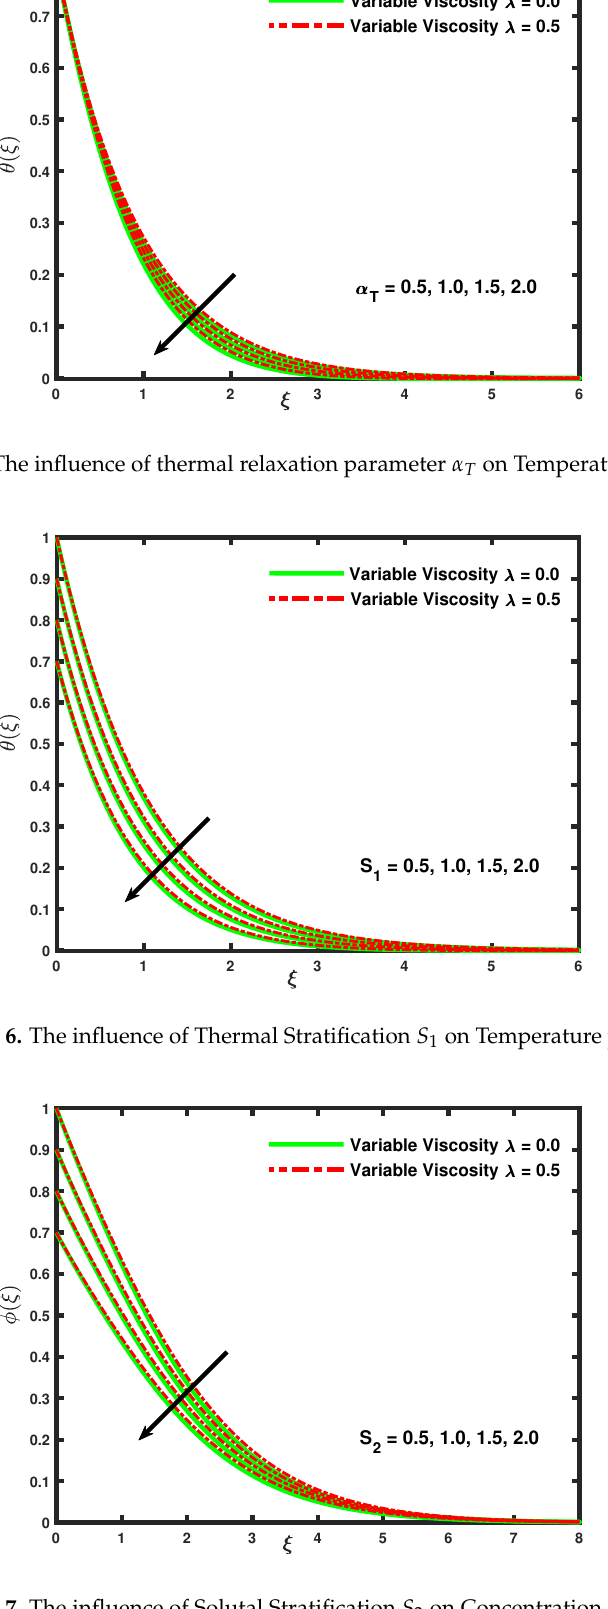
Figure 7. The influence of Solutal Stratification S 2 on Concentration